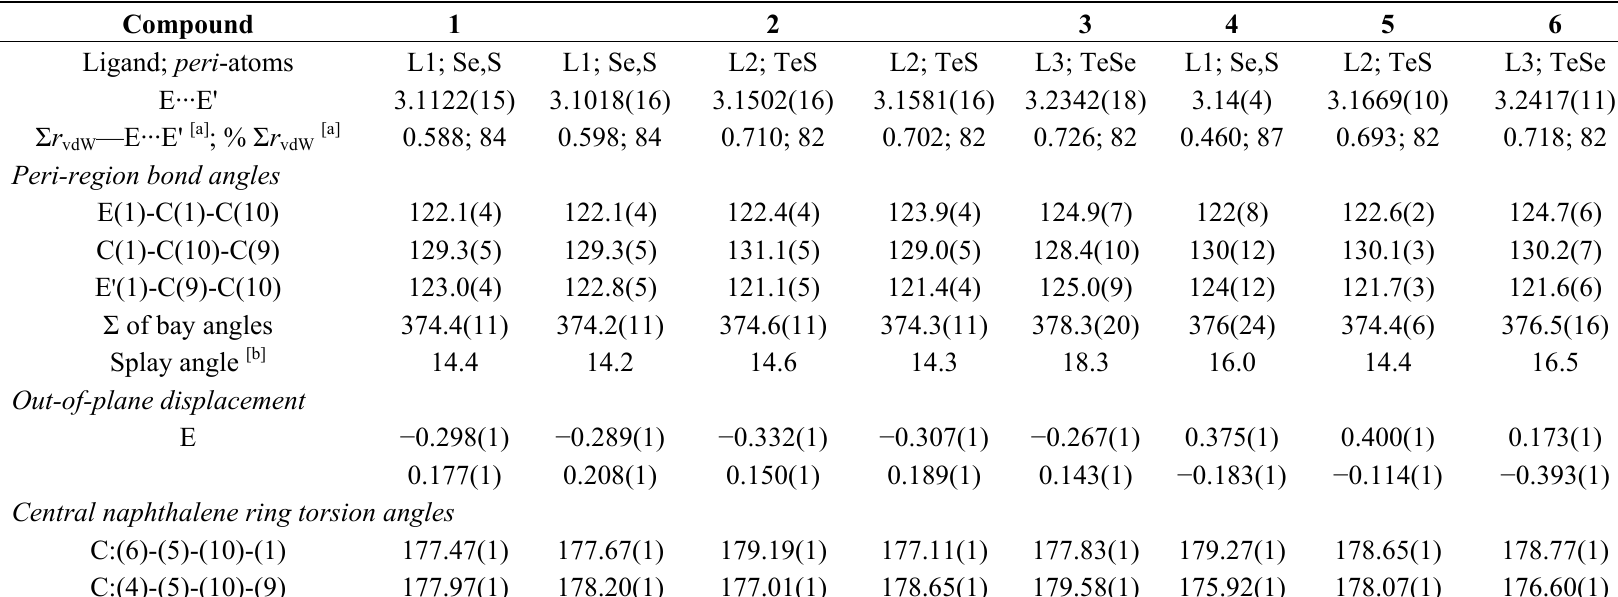
Table 2. Selected interatomic distances [Å] and angles [°] for 1 – 6